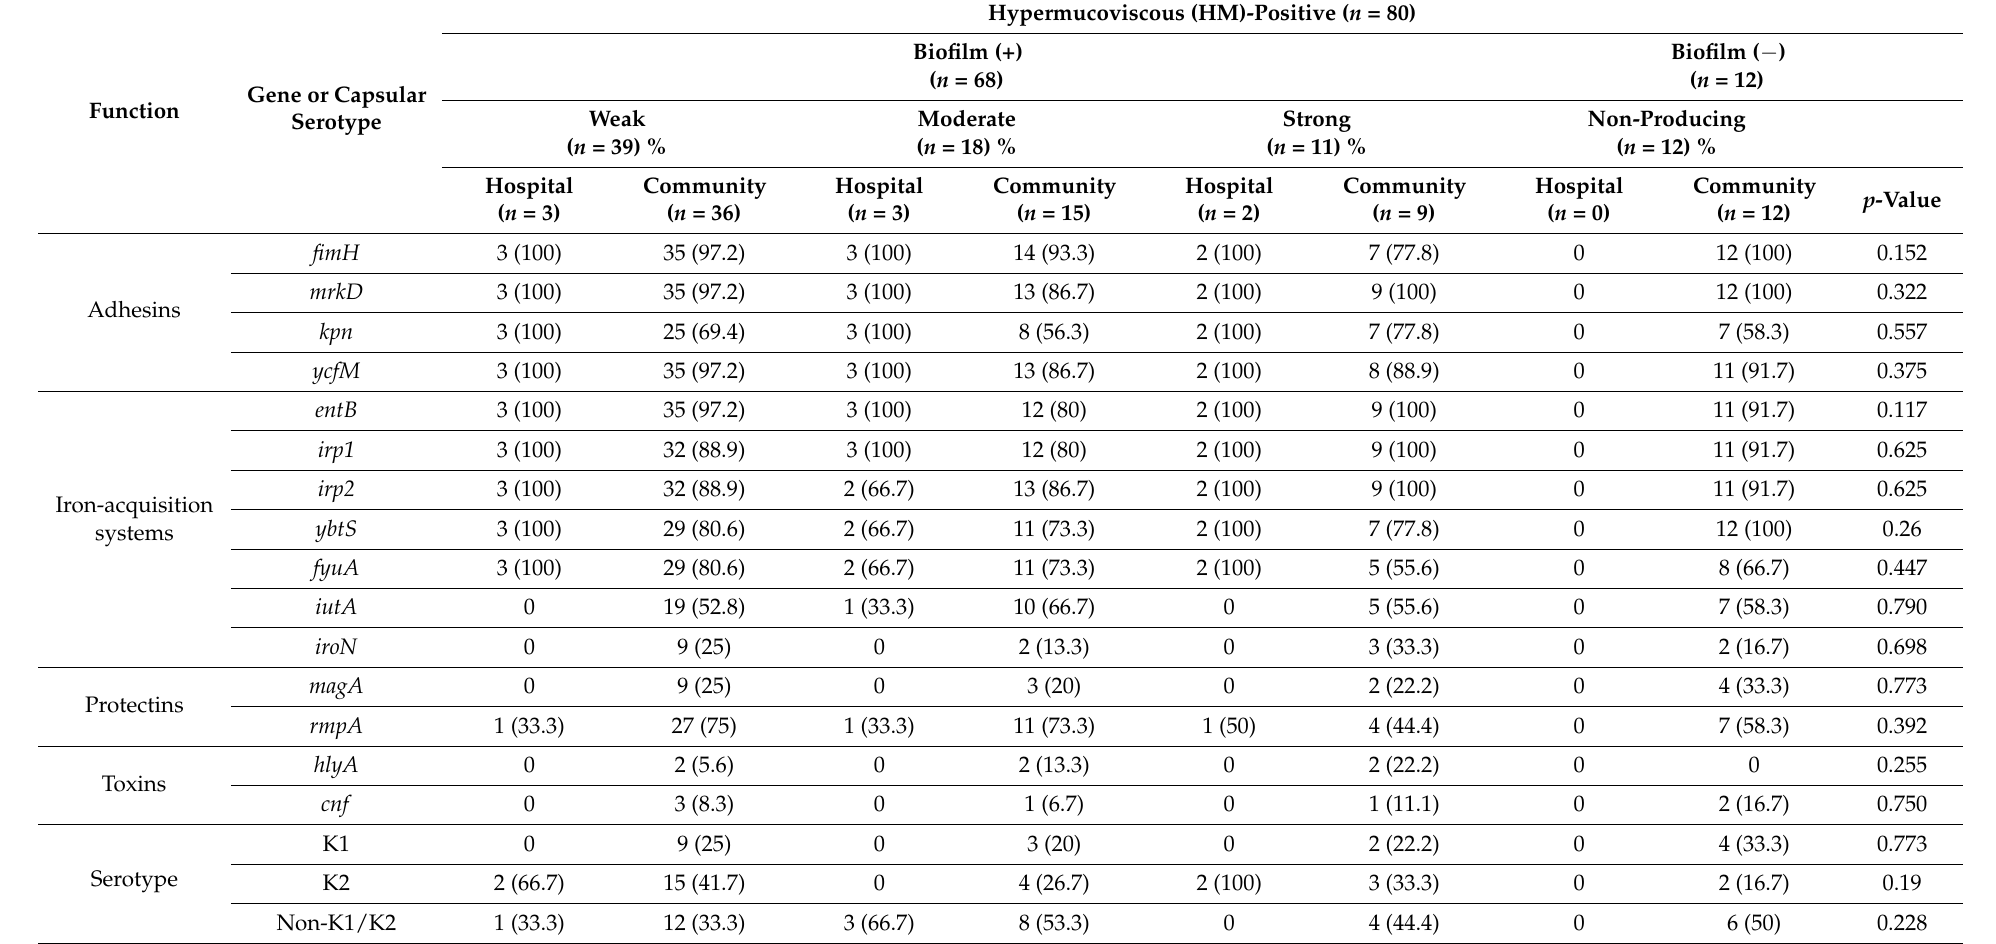
Table 4. Distribution of virulence genes according to hypermucoviscous (HM)-positive strains and biofilm formation of K. pneumoniae isolated from patients with hospital- and community-acquired